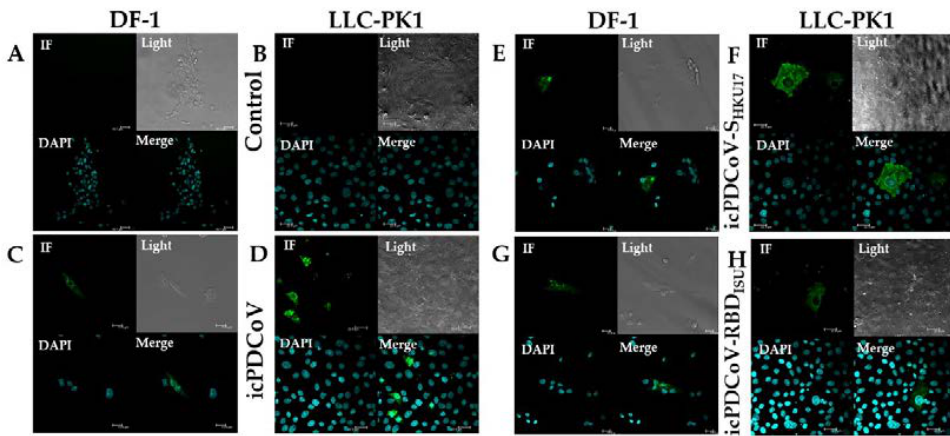
Figure 3. Indirect immunofluorescence imaging of PDCoV N antigen in DF-1 and LLC-PK1 cell lines. Cell lines were inoculated with mock inoculated ( A , B ), or inoculated with icPDCoV ( C , D ), icPDCoV-S HKU17 ( E , F ), and icPDCoV-RBD ISU ( G , H ) viruses at an MOI of 0.01. DF-1 and LLC-PK1 cells were fixed at 18 hpi or 12 hpi and stained using a mouse monoclonal, SD55-197 against PDCoV N protein, respectively. Representative images are shown (labeling for PDCoV N antigen in the infected cells (in green) and nuclei (in blue)). Scale bara of the zoom: 1.5 are 22.5.